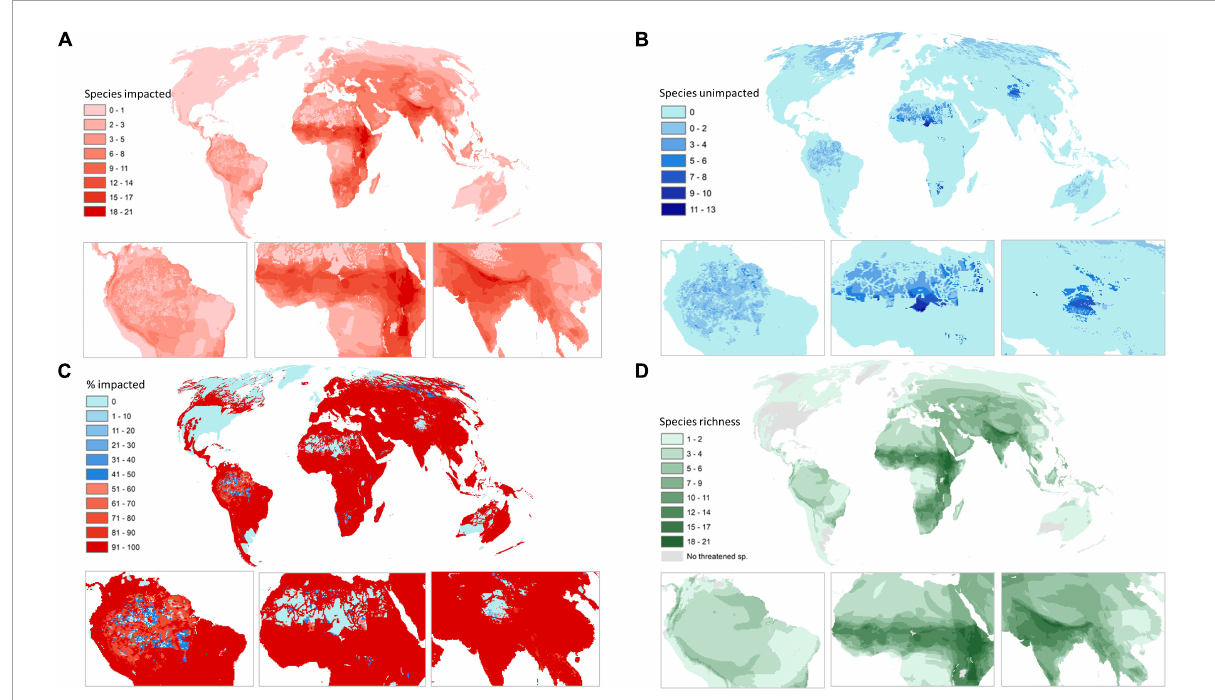
FIGURE1 The number of threatened and near threatened raptor species ( n = 172) impacted in a grid cell by at least one threat (A) . The number of raptor species in a grid cell not impacted by any threats (B) . The percentage of raptor species in a grid cell impacted by at least one threat (the inverse of which is the percentage not impacted) (C) . And the richness of threatened and near threatened raptors (D) . Maps use Mollweide equal area projection and a 30 × 30 km grid.